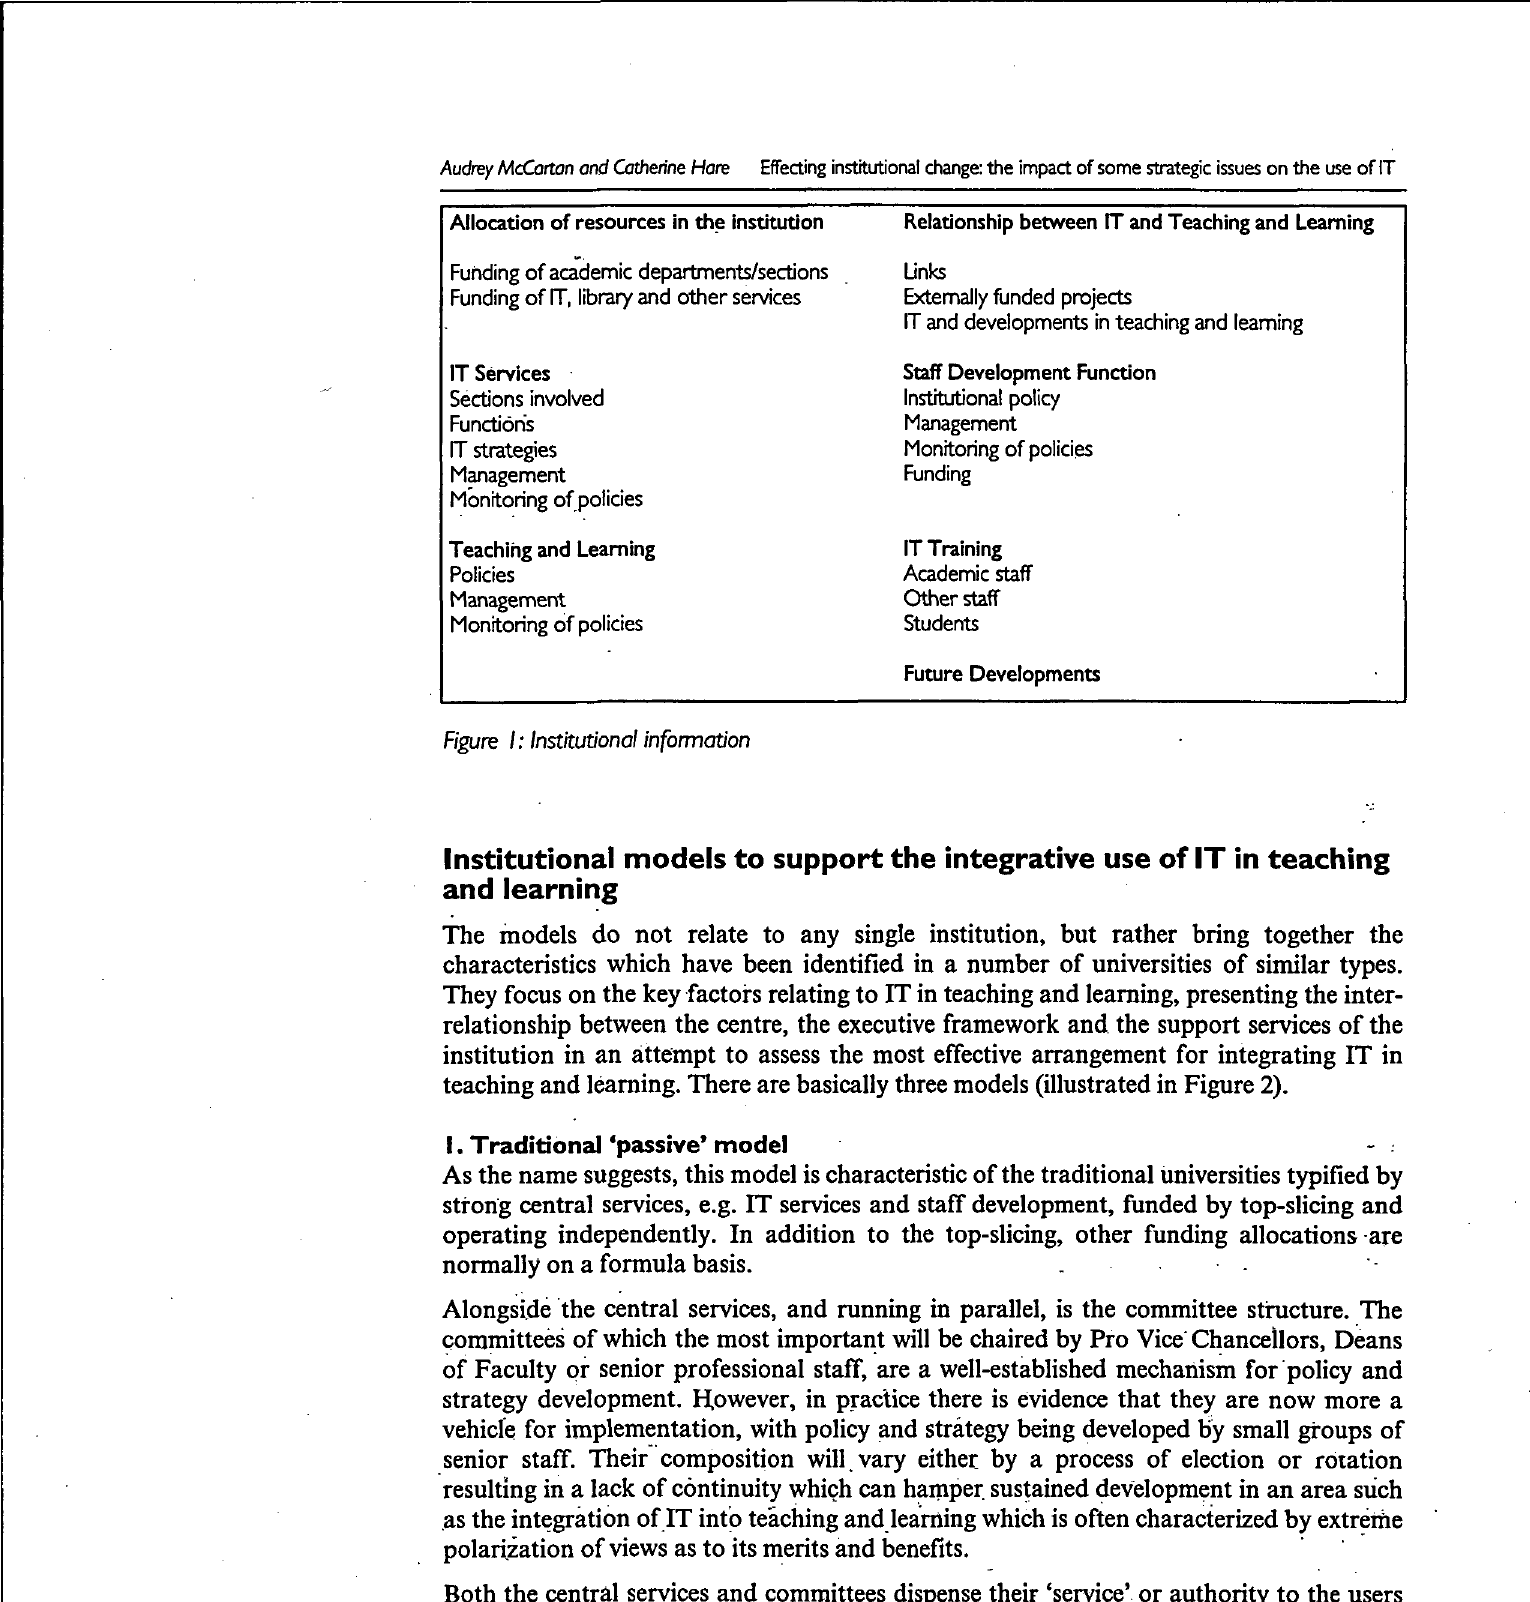
figure I: Institutional